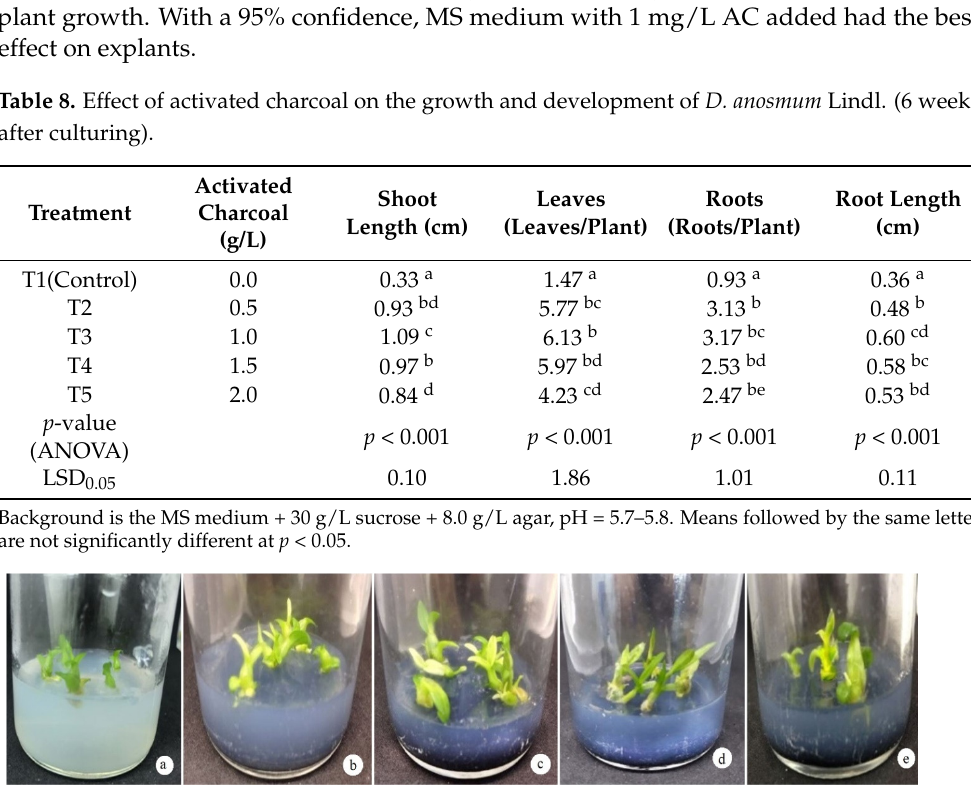
Figure 5. Effect of activated charcoal on the growth and development of D. anosmum Lindl. (6 weeks after culturing): ( a ) MS, ( b ) MS + 0.5 g/L AC, ( c ) MS + 1 g/L AC, ( d ) MS + 1.5 g/L AC, and ( e ) MS + 2.5 g/L